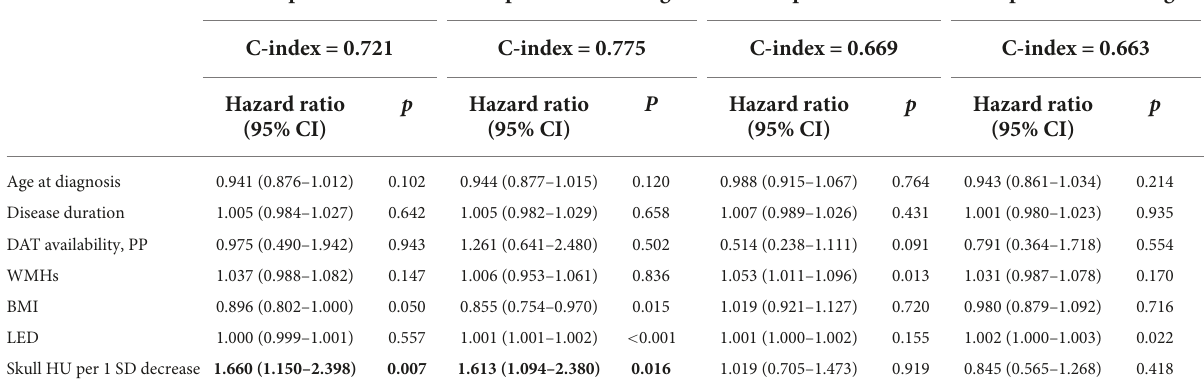
TABLE 4 Multivariate Cox hazard models for prediction of LID and wearing-off according to age